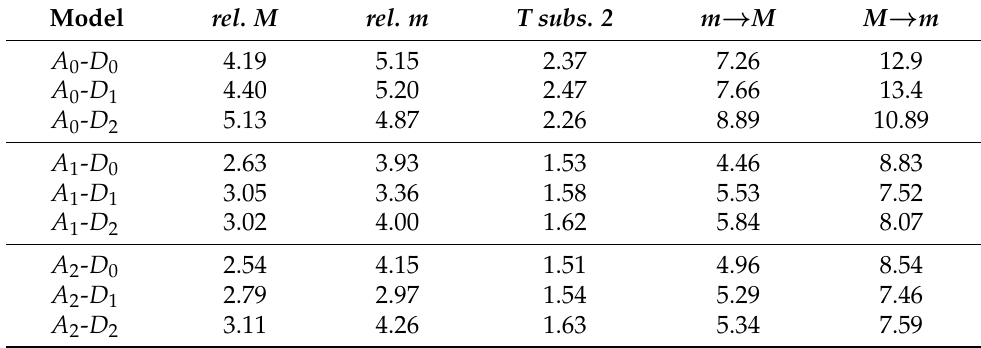
Table 3. Left: percentage of errors corresponding to usual chords substitutions rules, right: percentage of errors “major instead of minor” or inversely (% of the total number of